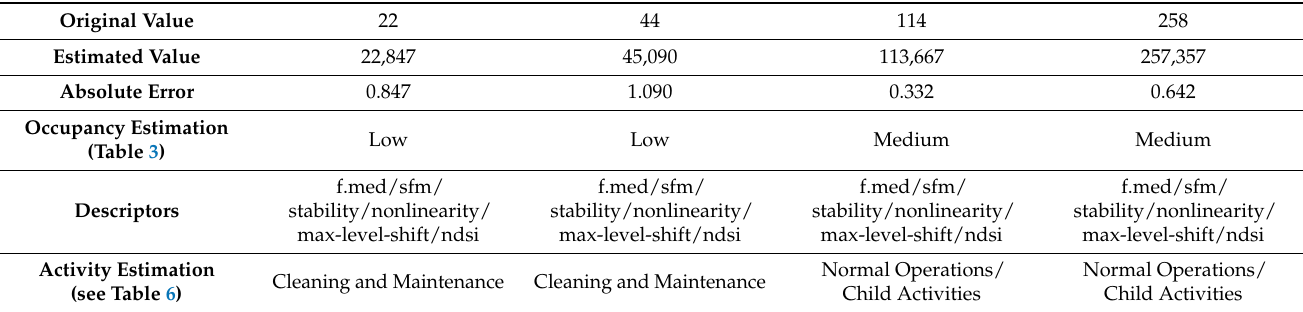
Table 12. Comparison between original values and the value of our model with estimated occupation and